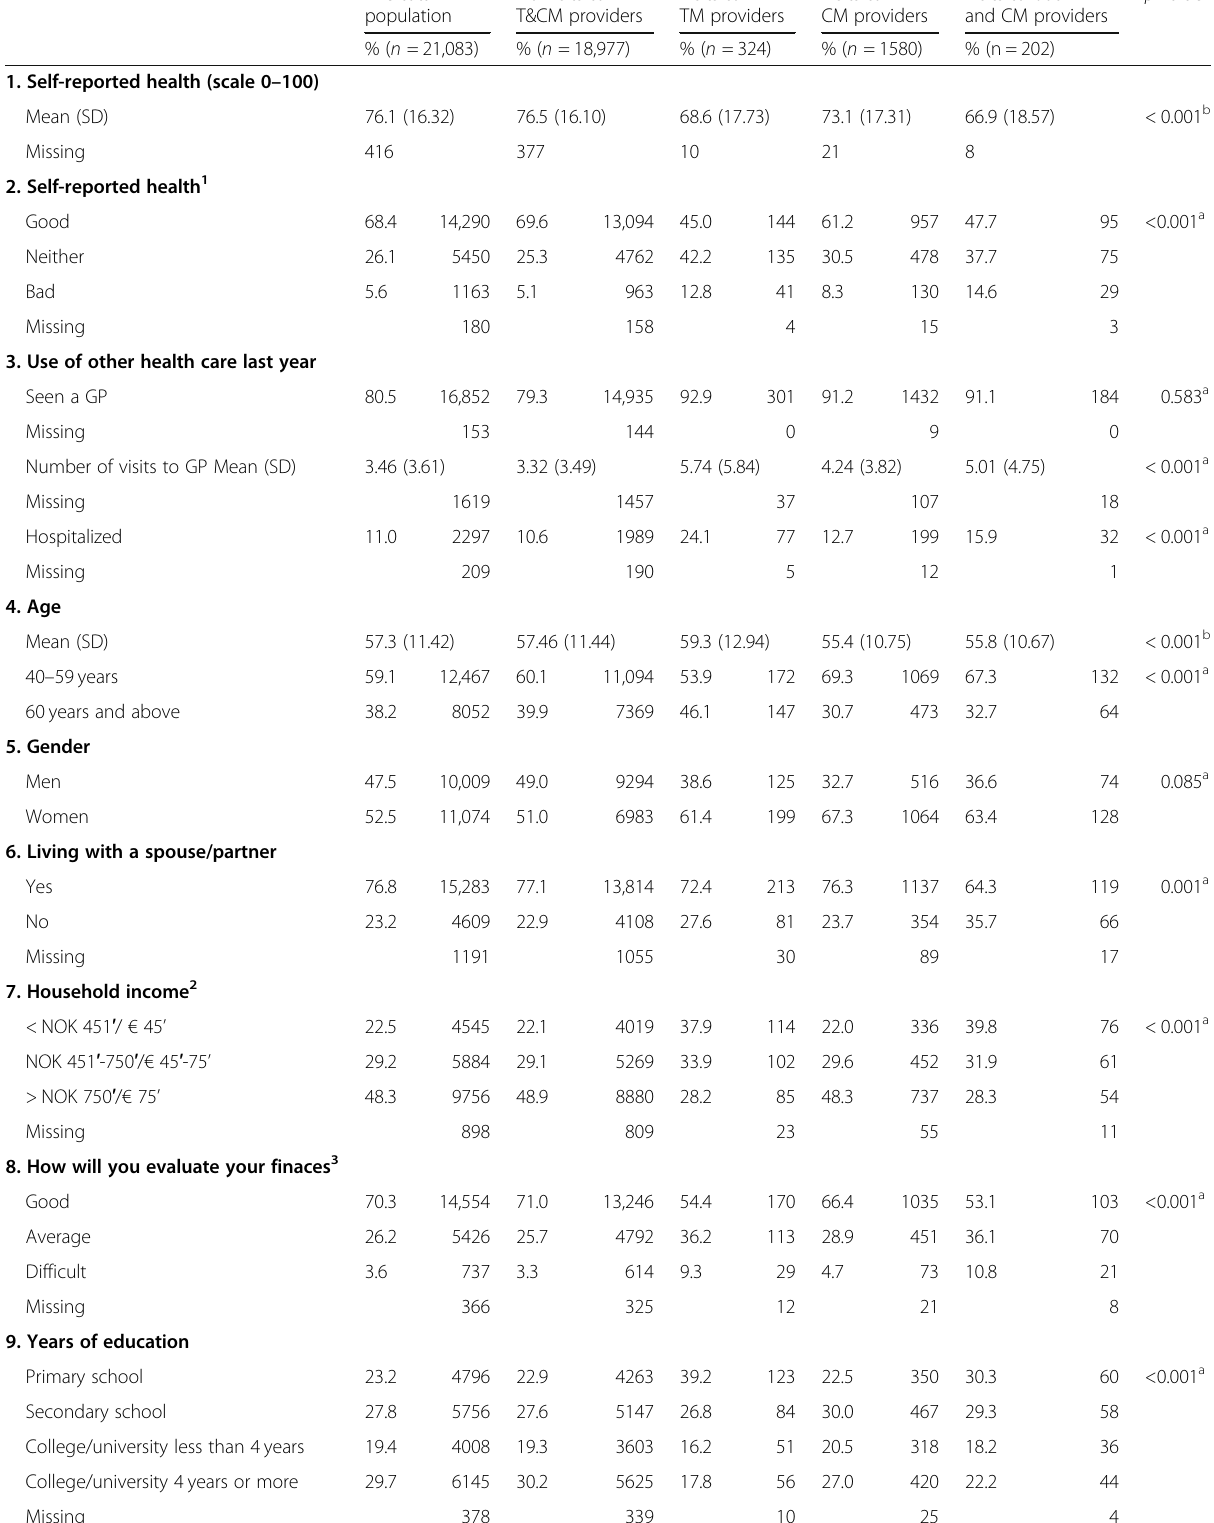
Table 1 Basic characteristics of the total sample and of the participants visiting TM providers, CM providers, and TM as well as CM